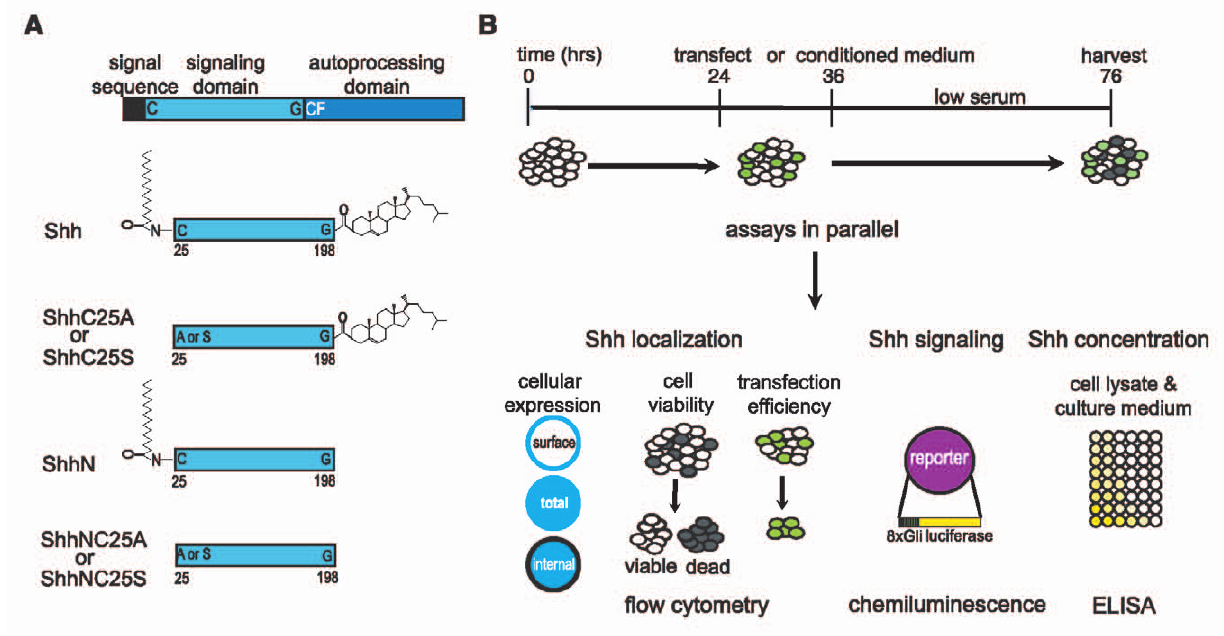
Figure 1. Schematics of experimentation. (A) Shh ligand lipidated with palmitate and cholesterol was generated from a full-length Shh open reading frame. Point mutation of the amino-terminal C25 to either an A or S was introduced to eliminate palmitoylation (ShhC25A, ShhC25S, ShhNC25A and ShhNC25S). Introduction of a stop codon after G198 eliminates cholesterol modification (ShhN, ShhNC25A, and ShhNC25S). (B) Assays of recombinant Shh protein concentration, cellular localization, and signaling were performed on transfected NIH3T3 fibroblasts harvested from the same or parallel wells. ELISA measurements of Shh protein concentration, flow cytometric analysis of cell expression, and chemiluminescence signaling assays in NIH3T3 fibroblasts co-transfected with recombinant Shh, EGFP, Gli-reporter, and LacZ were integrated to determine the contributions of each lipid adduct on Shh secretion, cellular localization, and signaling potency.